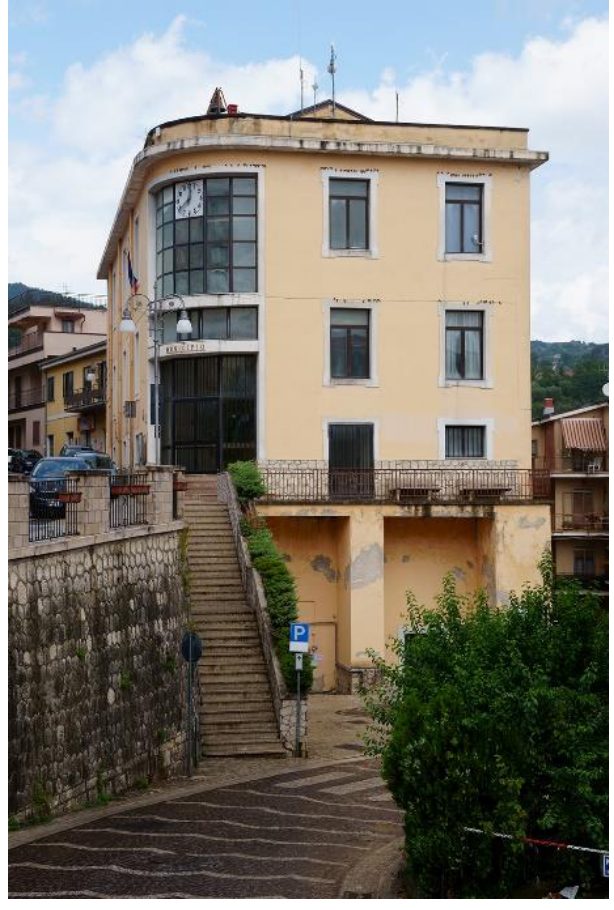
Figure 44. Caposele: the Town Hall in the historical center (photos by [35,36]).